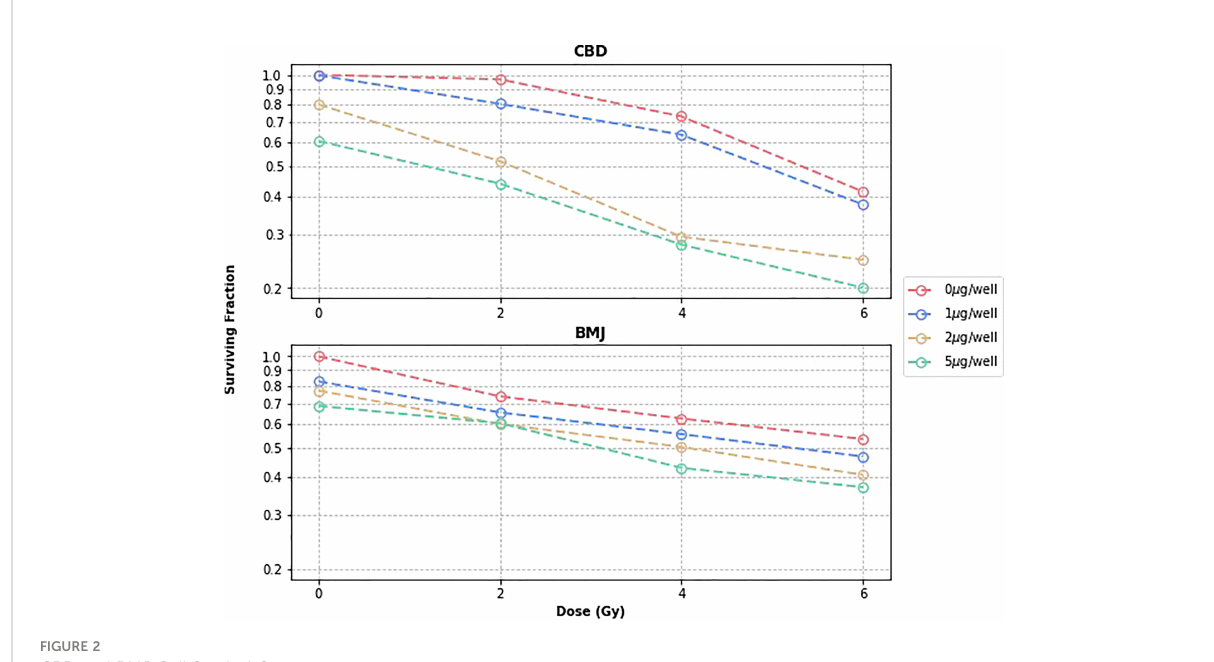
FIGURE 2 CBD and BMJ Cell Survival Curves.